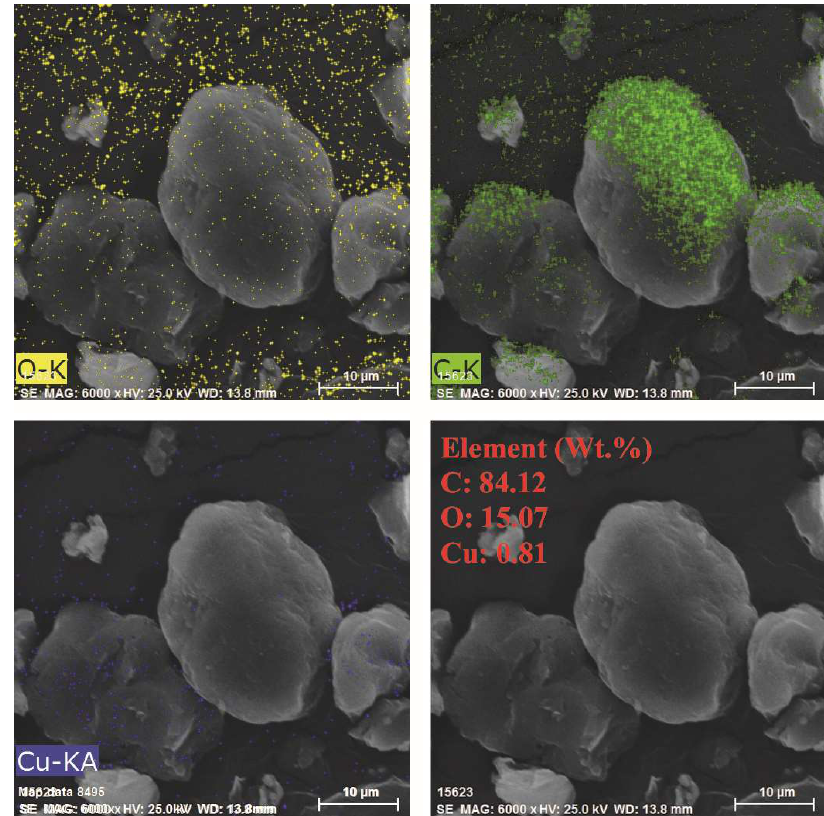
Figure 13. SEM-EDS result of the liberated graphite electrode material.